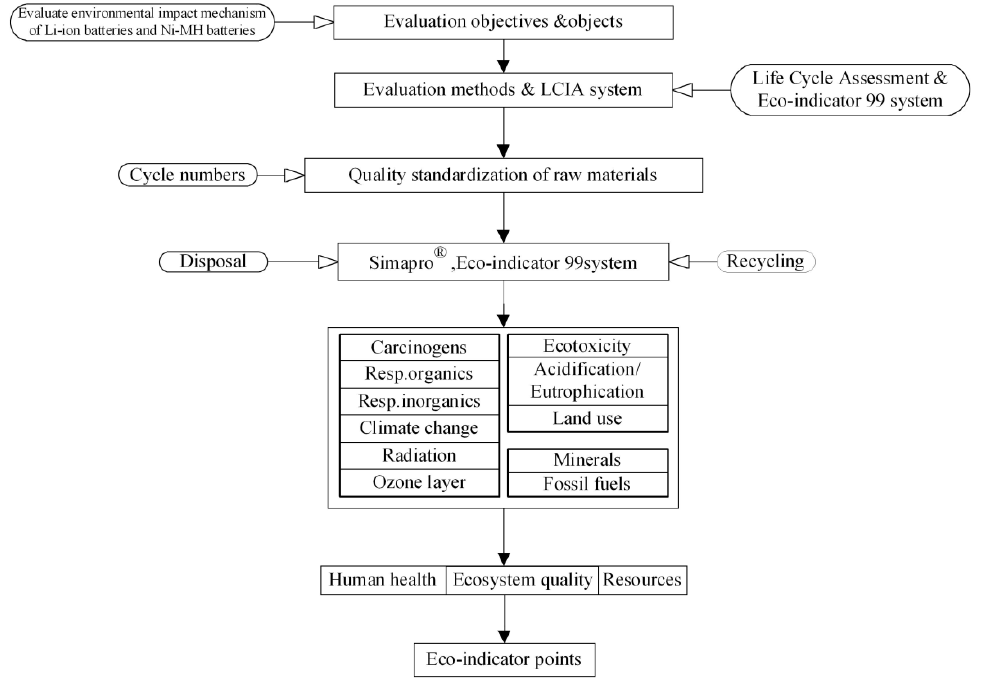
Figure 2. Research steps of the secondary battery environmental impact